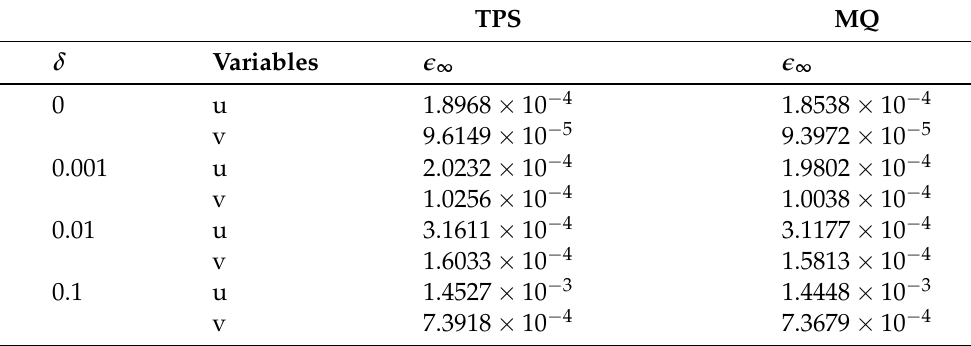
Figure 2. Plot of the exact solution ( a ) and plot of the approximate solution ( b ) related to u , and plot of the exact solution ( c ) and plot of the approximate solution ( d ) related to v with TPS for Example 1 by taking dx = 1 Table 3. The effect of noise on error estimates of Example 1 for N = 1848, τ = 0.5 ( dx ) 2 , and n c =